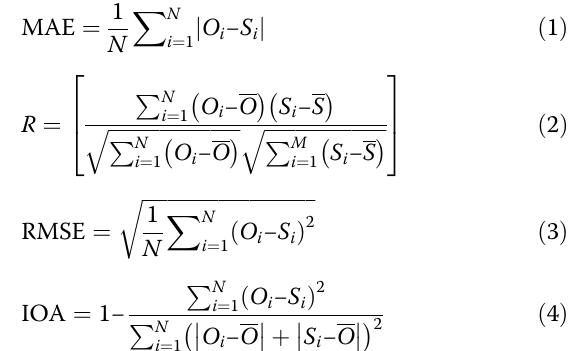
Table 1 Configuration of WRF